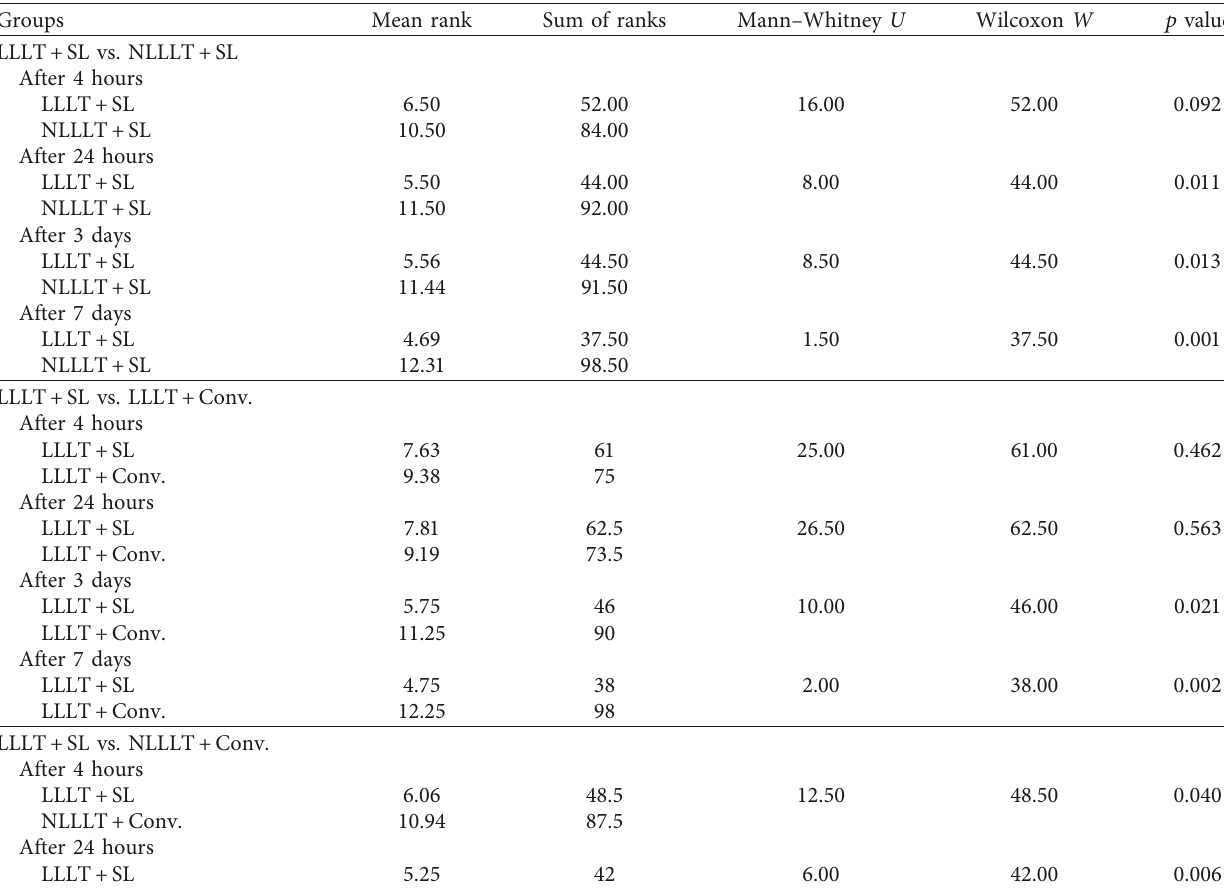
Table 3: Continuous step-by-step comparison between 2 groups using Mann–Whitney U